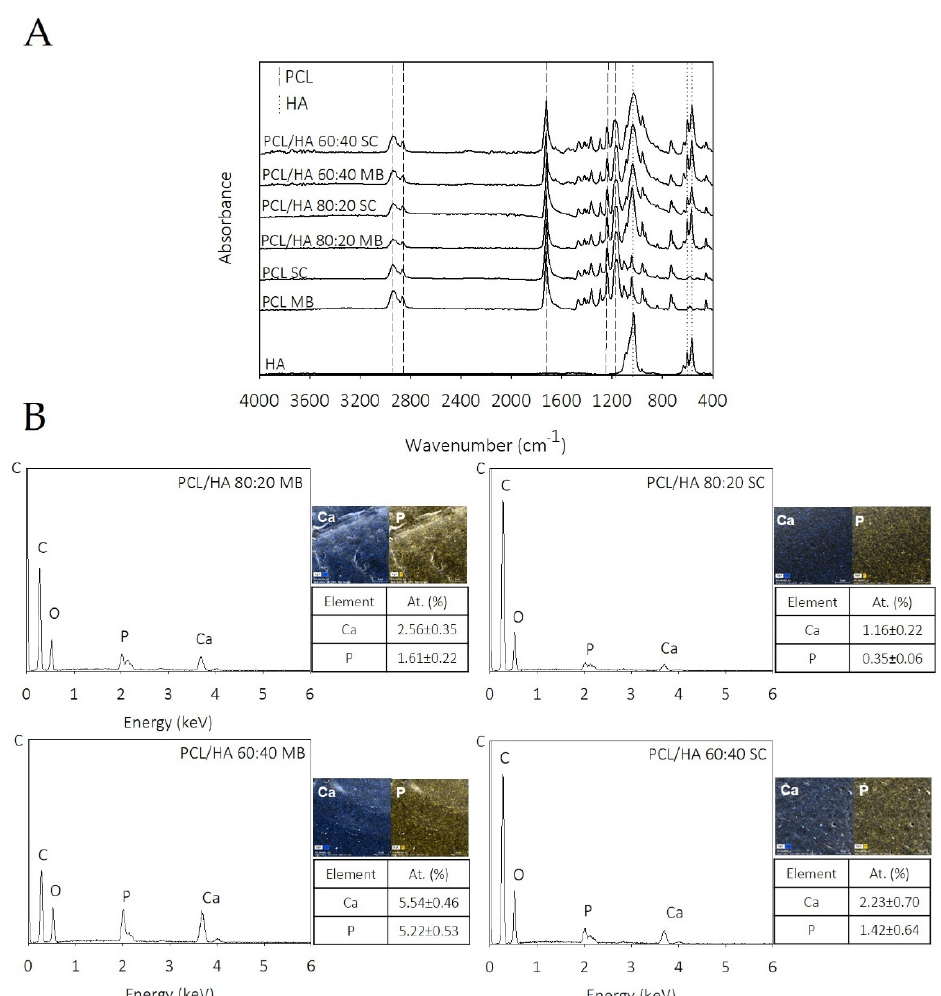
Figure 1. FTIR spectra of pure HA and PCL/HA composites ( A ), and EDX analysis and elemental mapping results showing the elemental composition of PCL/HA composites with predominant calcium and phosphorous atoms ( B ).